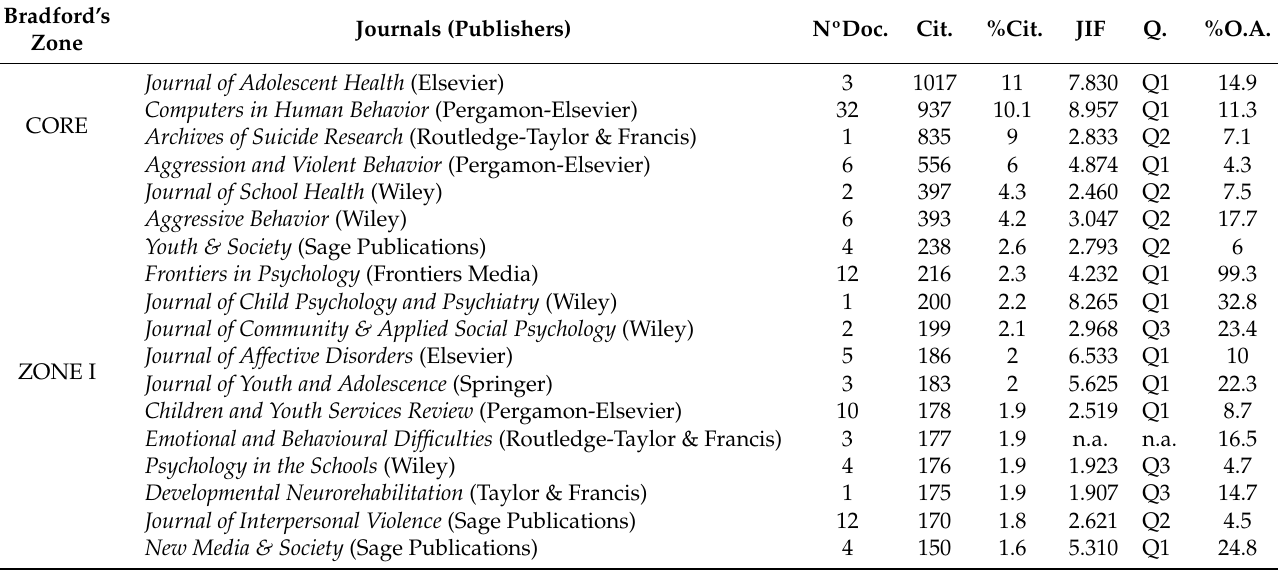
Table 2. Bradford’s Core and Zone I journals according to the number of